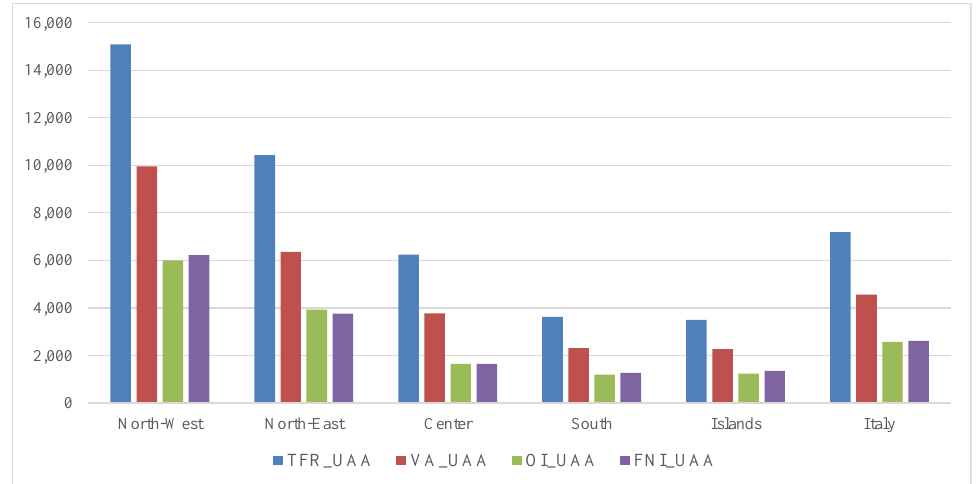
Figure 7. Economic indices of small farms by utilized agricultural area (UAA) and by district. Source: Our elaboration on FADN data, 2018–2020.